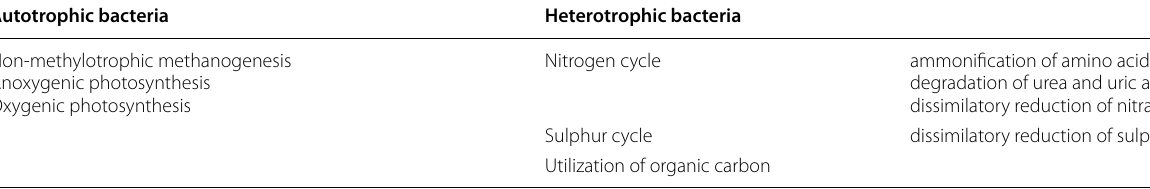
Table 1 Different metabolic pathways of calcium carbonate precipitation Autotrophic